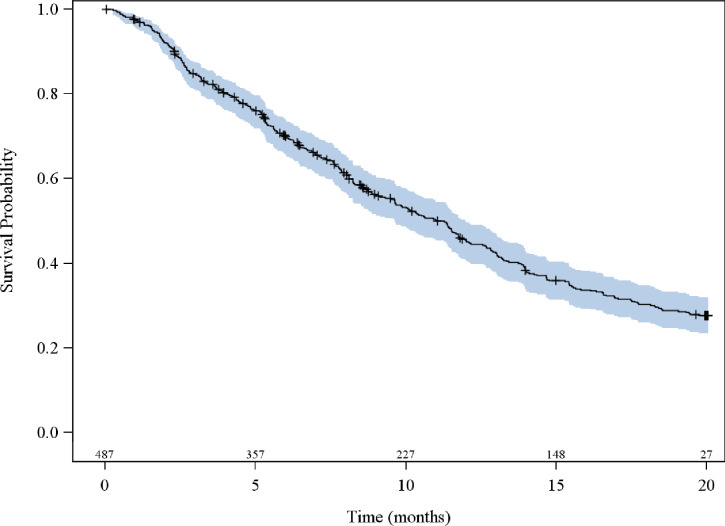
Kaplan-Meier plot for progression-free survival of mCRC patients on first-line cetuximab.